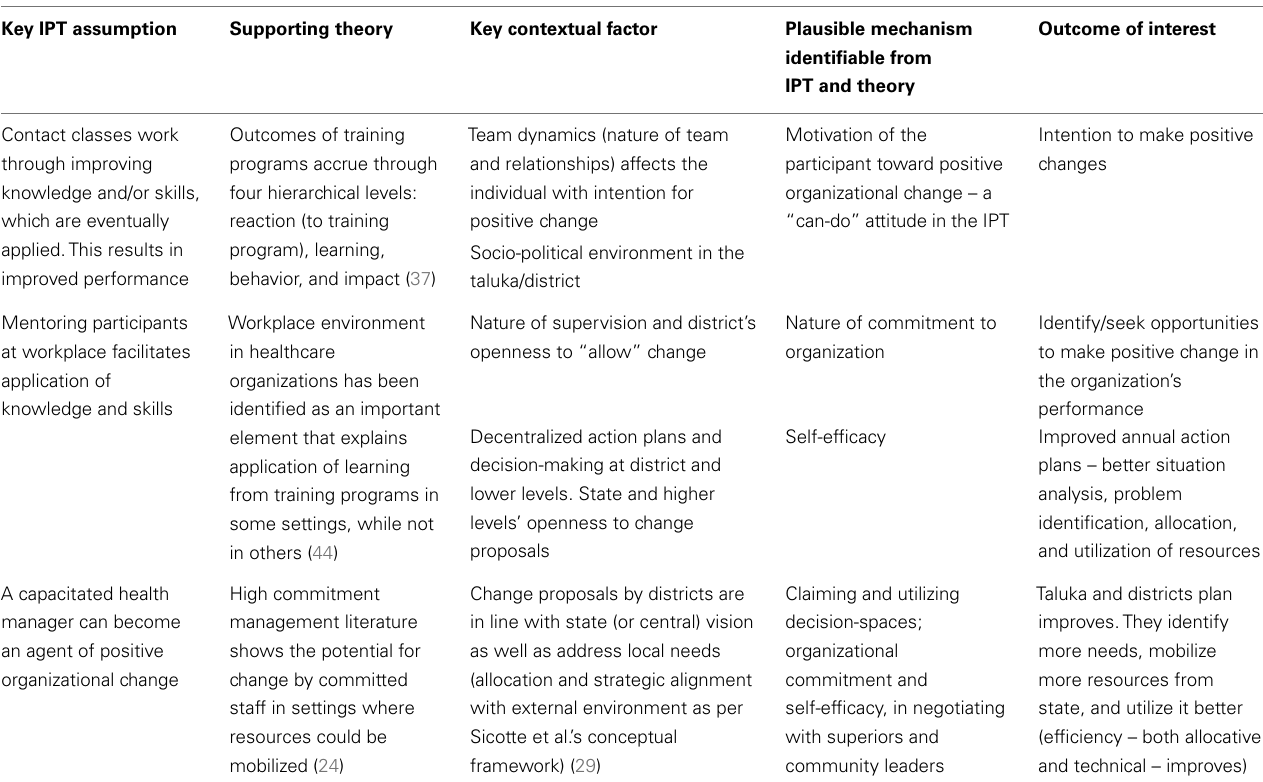
Table 2 |Table showing the progression from initial program assumptions toward explanatory mechanism, plausible contextual factors, and supporting theory, in relation to the expected outcome